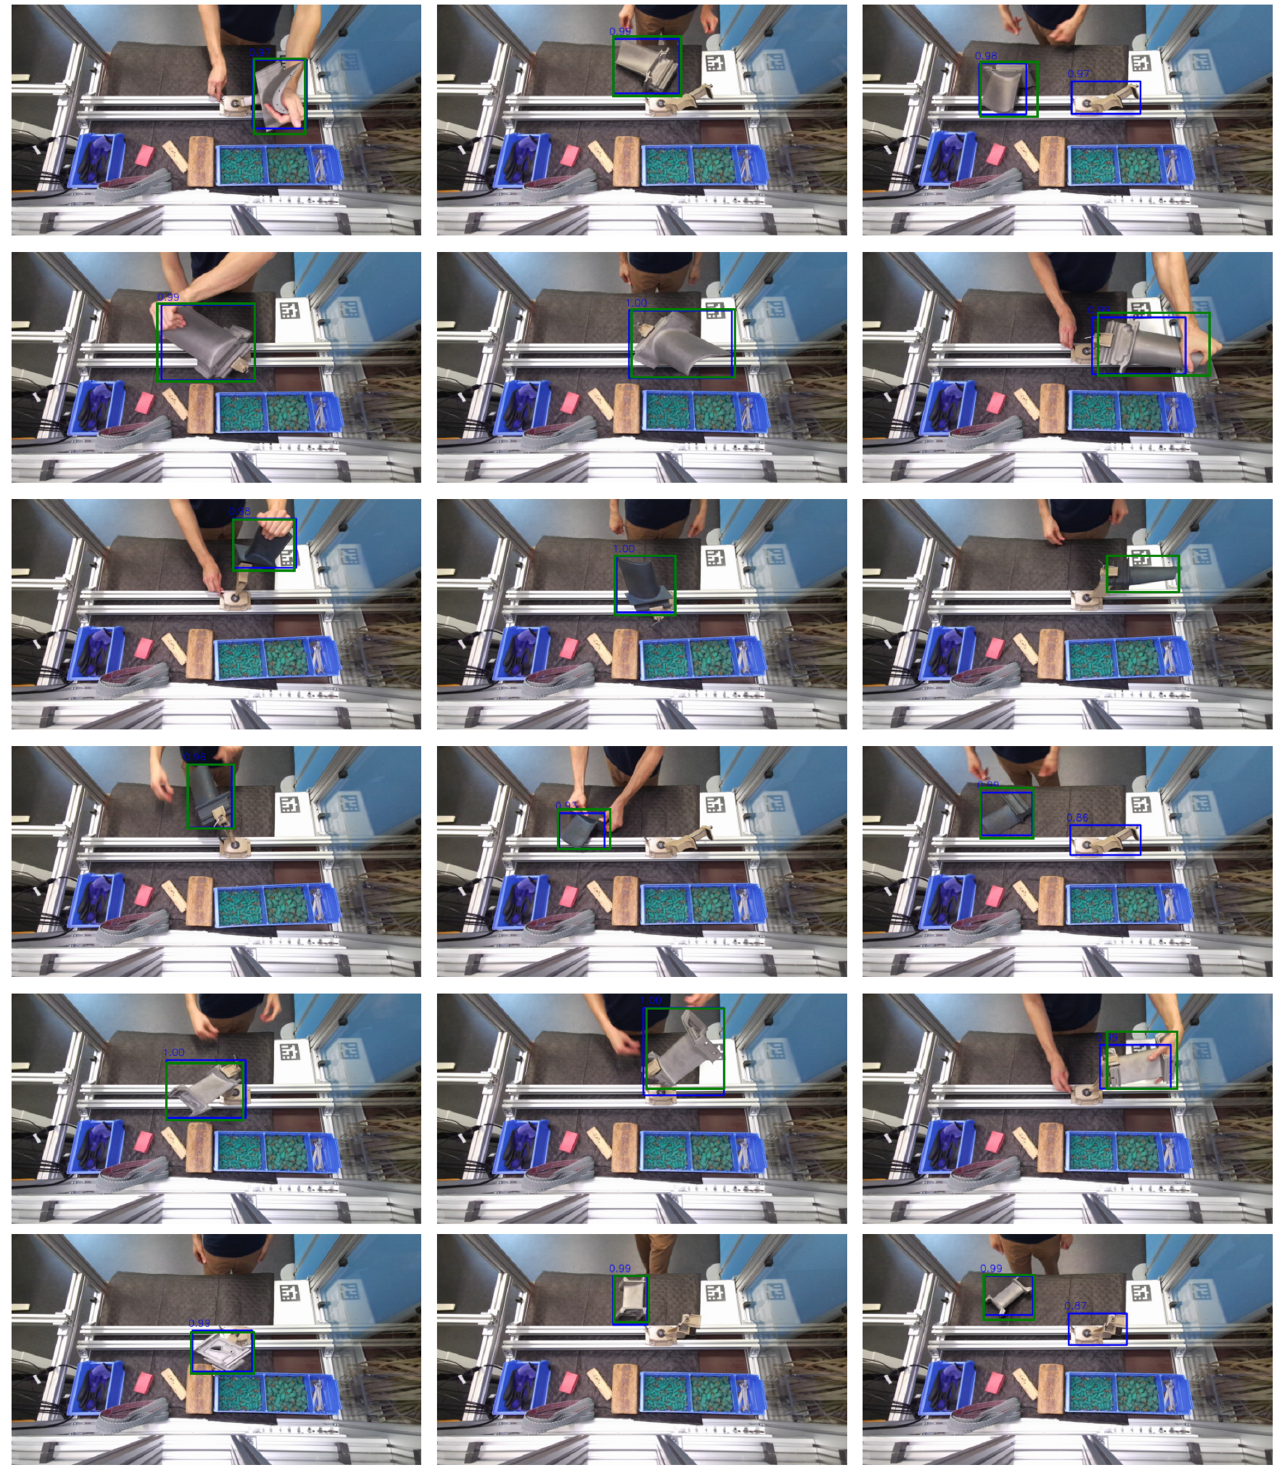
Figure 2. Object detection results on real test data from our three Faster R-CNN models trained purely on 5000 synthetic PBR images each. Predictions are blue (including detection confidence) and manually created ground truth labels are green. The last column shows some